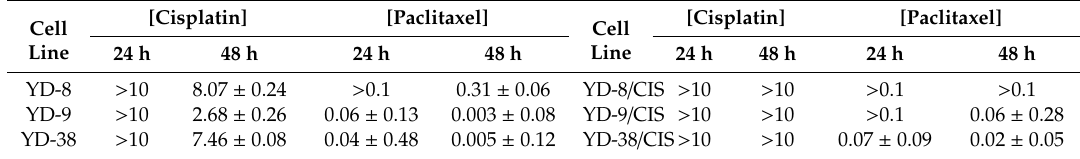
Table 1. IC 50 values ( µ g / mL) of cisplatin and paclitaxel in OSCC